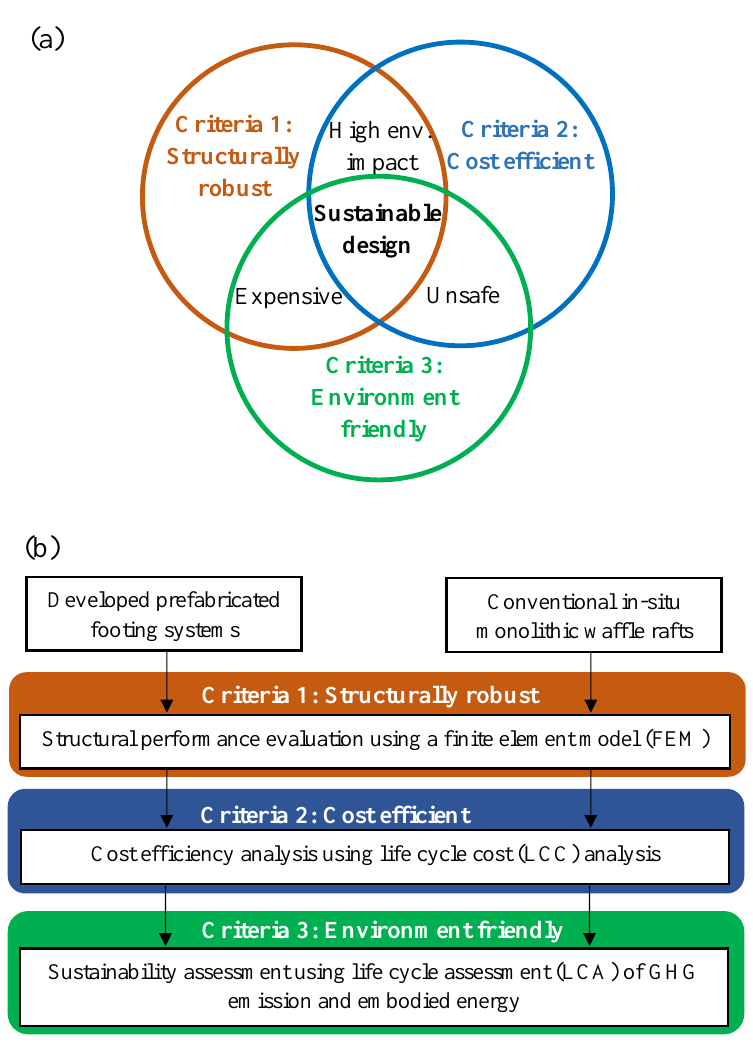
Figure 2. Methodology of the study: ( a ) the concept of the multi-criteria analysis to achieve a sustainable design and ( b ) the multi-criteria comparison between the developed prefabricated footing systems and the conventional in-situ monolithic waffle